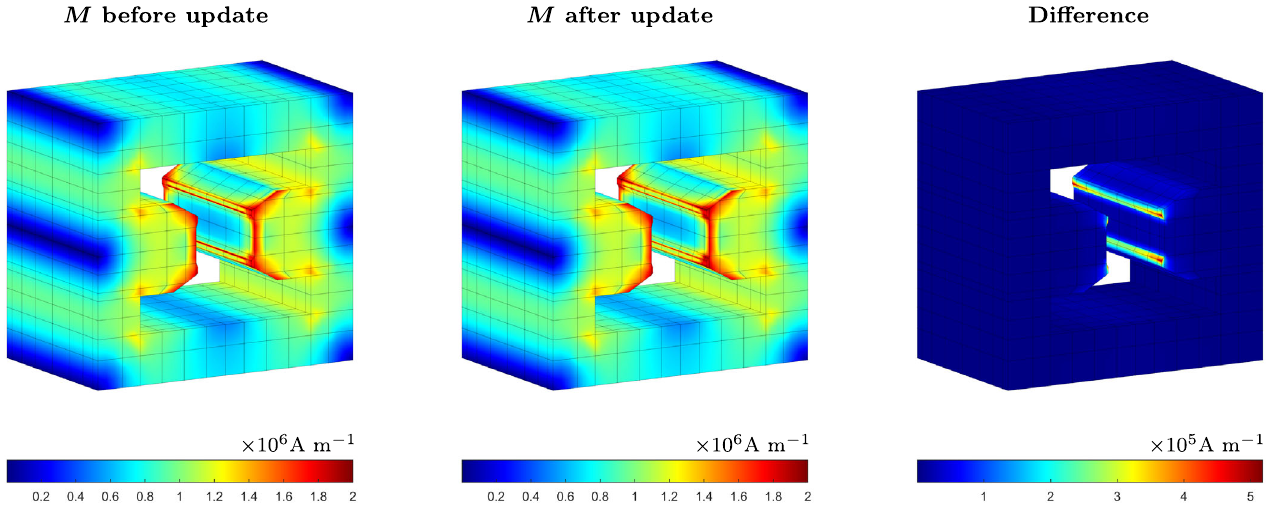
FIG. 6. Magnetization update for 200 A. The magnetization distribution before (left) and after (center) the updating is shown. The absolute difference is also shown